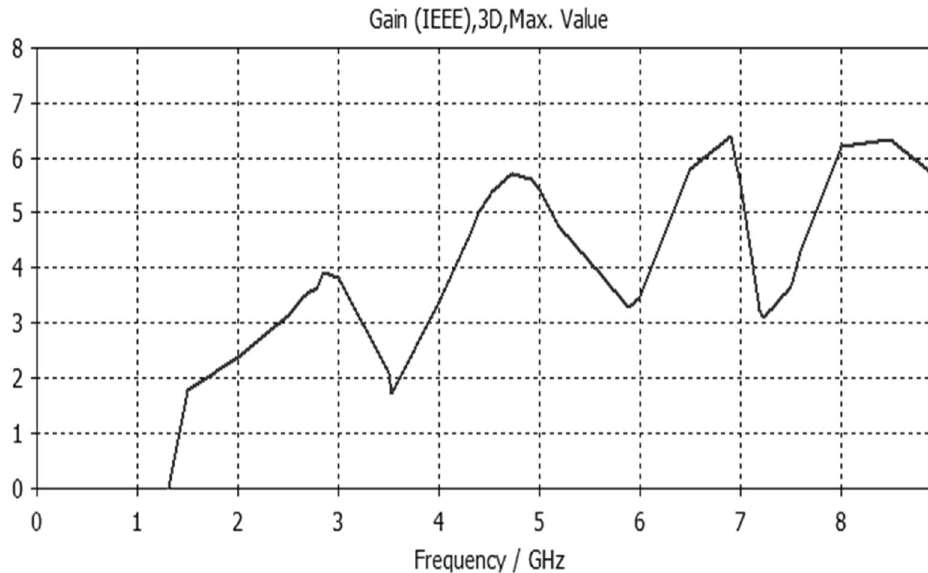
Figure 10. Gain result for Antenna2.